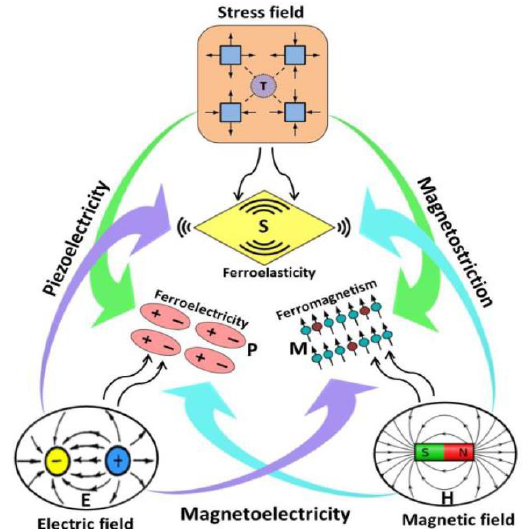
Figure 18. Schematic illustration of magnetic-elastic-electric couplings in multiferroic materials. Here, M is magnetization, S is mechanical strain, and P is dielectric polarization. Reprinted with permission from [103]. Copyright 2019 MDPI Publishers.